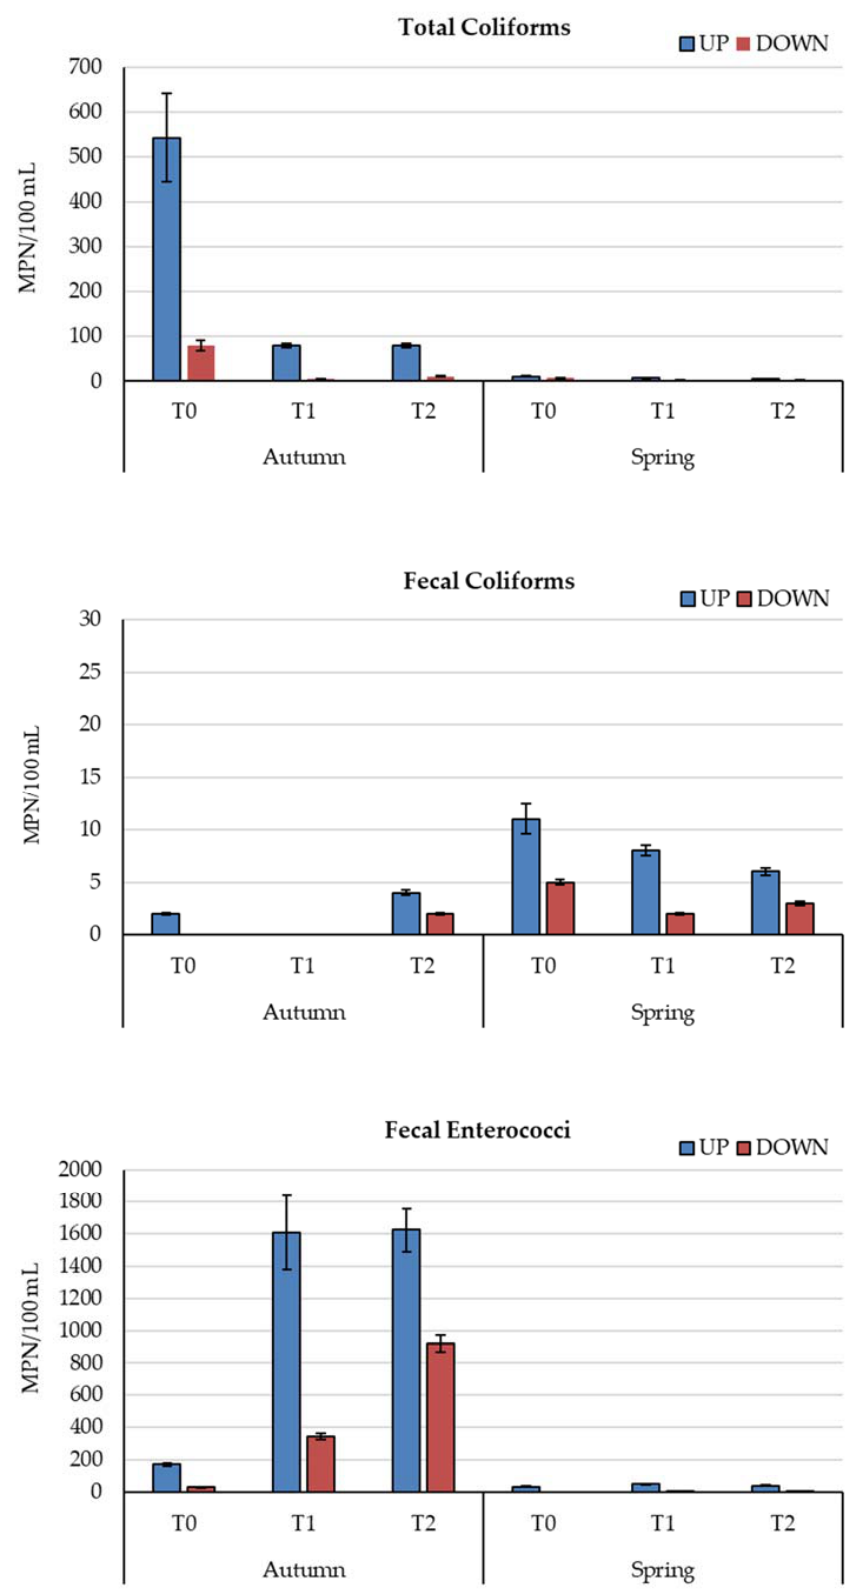
Figure 3 . Fecal contamination indicators (mean values ± standard errors) in wastewater upstream (UP) and downstream (DOWN) of the sponge Hymeniacidon perlevis at each sampling time (T0, T1, T2) during both sampling periods (autumn and spring).